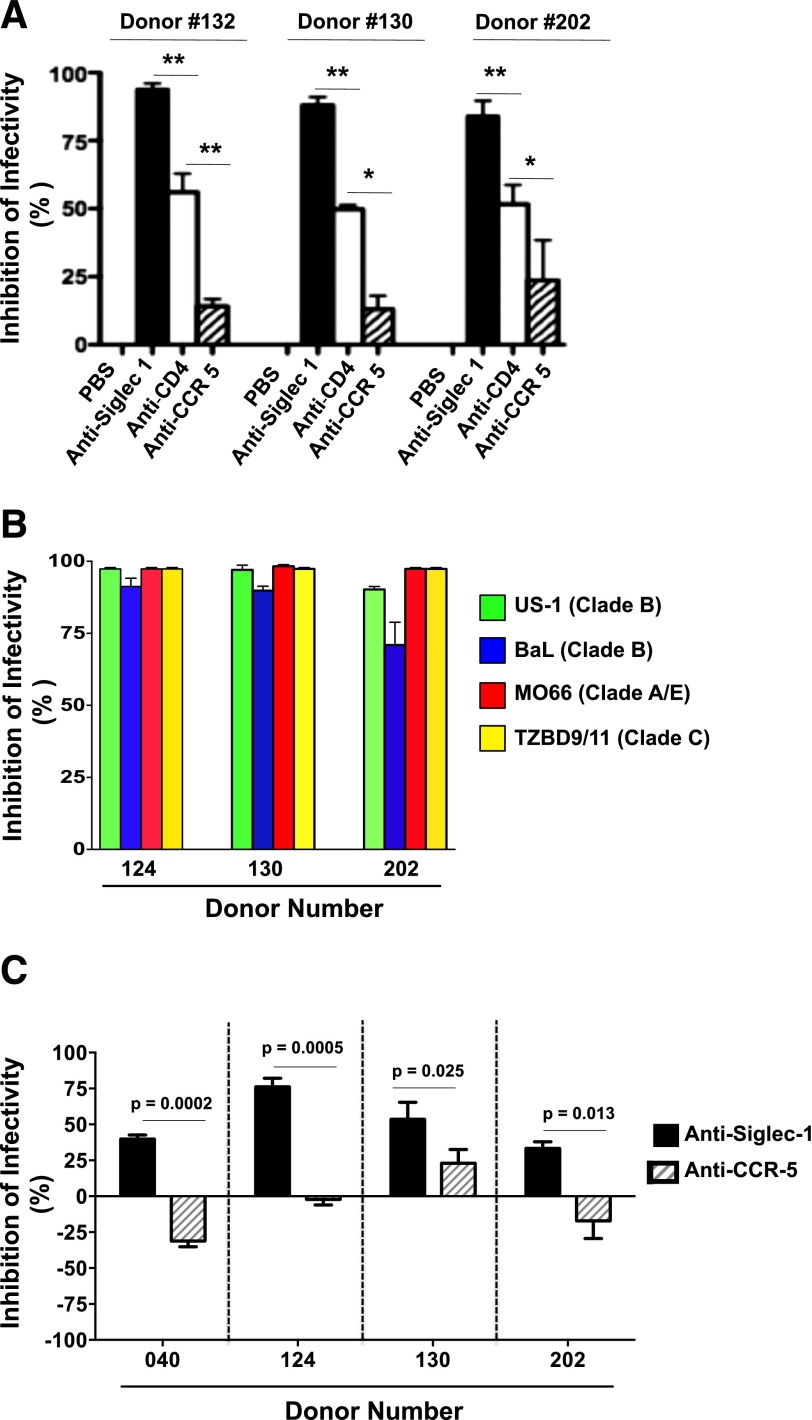
Siglec-1 is a major HIV-1 receptor on MDMs.Triplicate wells of M-CSF–derived MDMs were preincubated with PBS or with mAbs specific for Siglec-1, CD4, or CCR5 and were subsequently infected for 90 min with either BaL (A), with different virus clades (B), or for 30 min with US-1 (C). (A) Bar graphs show the percentage inhibition of infectivity (means ± sd) with anti-Siglec-1 mAbs (filled bars) or with anti-CCR5 mAbs (hatched bars). (B). Bar graph shows percentage inhibition of infectivity (means ± sd) with 4 primary viruses belonging to subtypes B (US-1, BaL), A/E (MO66), and C (TZBD9/11) with anti-Siglec-1 mAbs. (C) Bar graph shows percentage inhibition of virus entry (means ± sd) with anti-Siglec-1 mAbs (filled bars) or with anti-CCR5 mAbs (hatched bars). Data are representative of 3 independent experiments. The percentage inhibition of virus entry was calculated as described in the “Materials and Methods.”